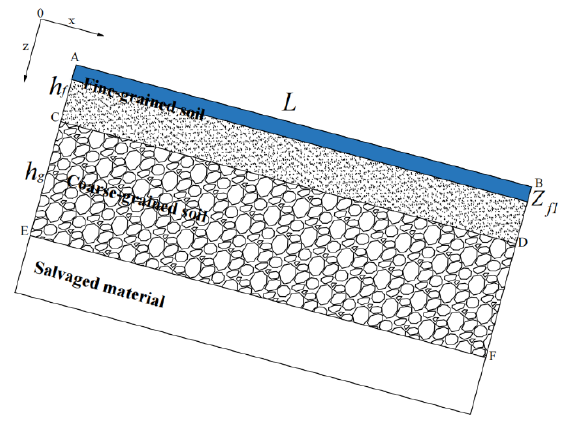
Figure 2. Scheme of the initial stage of water infiltration. As the rain goes on, the water infiltrates continuously and starts to move downward along the slope. Assuming the water in the fine-grained soil is linearly distributed in both parallel and vertical directions. When the water content of the fine-grained soil reached the breakthrough point of the capillary barrier at the toe of the slope, the water content of each point in the fine-grained soil is: